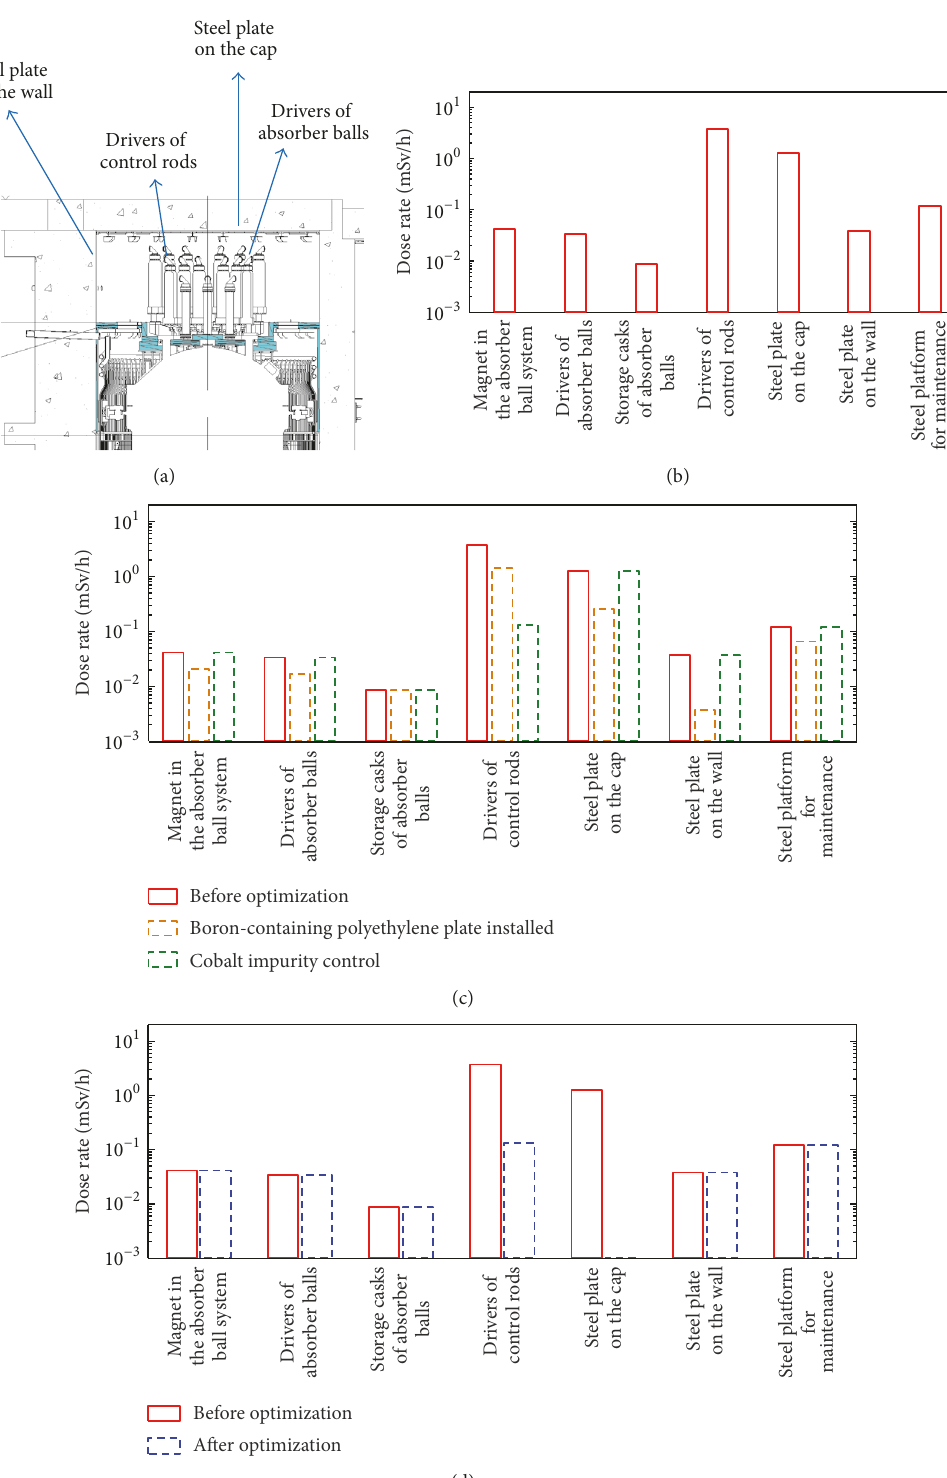
Figure 3: (a) The dose reduction design for the maintenance work on top of RPV; (b) dose rates of different equipment for the maintenance work on top of RPV; (c) dose rates before optimization and after boron-containing polyethylene plate installed or cobalt impurity control; (d) dose rates before and after